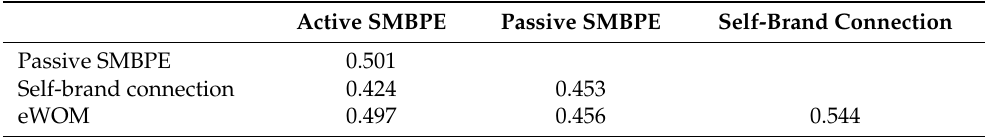
Table 2. Discriminant validity